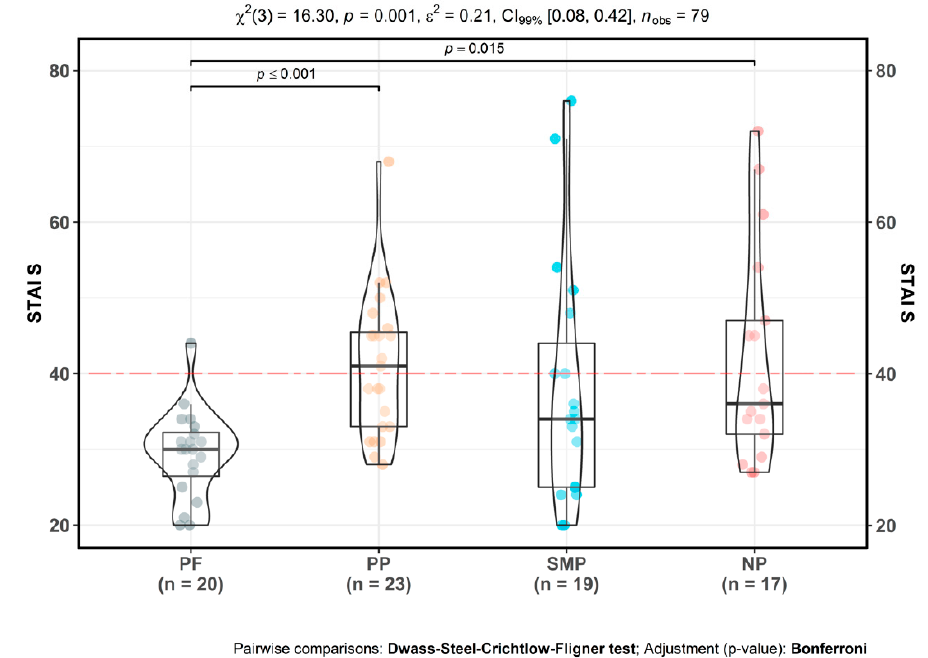
Figure 4. State anxiety in CP. PF: pain-free participants. PP: primary CP participants, SMP: secondary musculoskeletal CP participants, NP: neuropathic CP participants. Mean values: PF µ = 29.45, CI 95% (26.73, 32.17), PP µ = 41.04, CI 95% (36.92, 45.16), SMP µ = 37.95, CI 95% (30.28, 45.62), NP µ = 41.82, CI 95% (34.53, 49.11). Red dotted line indicates clinical cut off for state anxiety symptoms. Scores above 40 indicate clinical levels of anxiety [67].